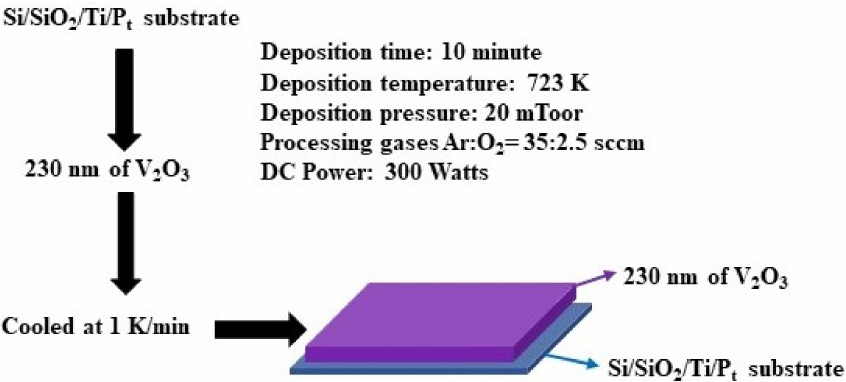
Scheme 1. Schematic diagram for growth of V2O3 thin